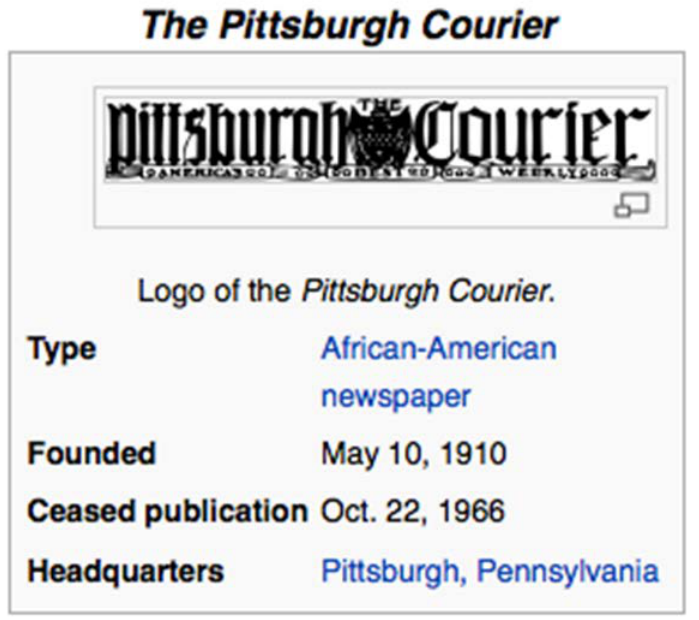
Figure 1 Infobox for the Pittsburgh Courier. Infoboxes are templates used in Wikipedia to improve the appearance of articles and to ensure consistency of presentation for articles on similar topics (“Wikipedia: Infobox,”